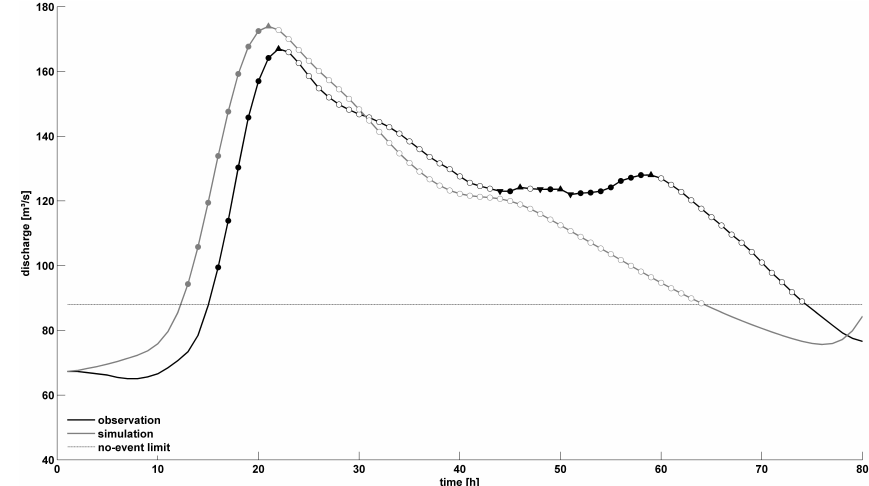
Fig. 5. Example of a matching observed (black) and simulated (grey) event (detail of event 5 in Fig. 4). The hydrological case is shown for each point: “rise” (filled circle), “peak” (upward triangle), “recession” (empty circle), “trough” (downward triangle), “no event” (no marker). The “no-event” threshold (thin grey line) separating events from low flow conditions is set to 88m 3 s − 1